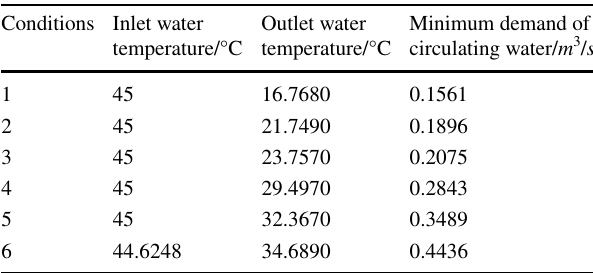
Table 5 Calculation values of various state parameters under